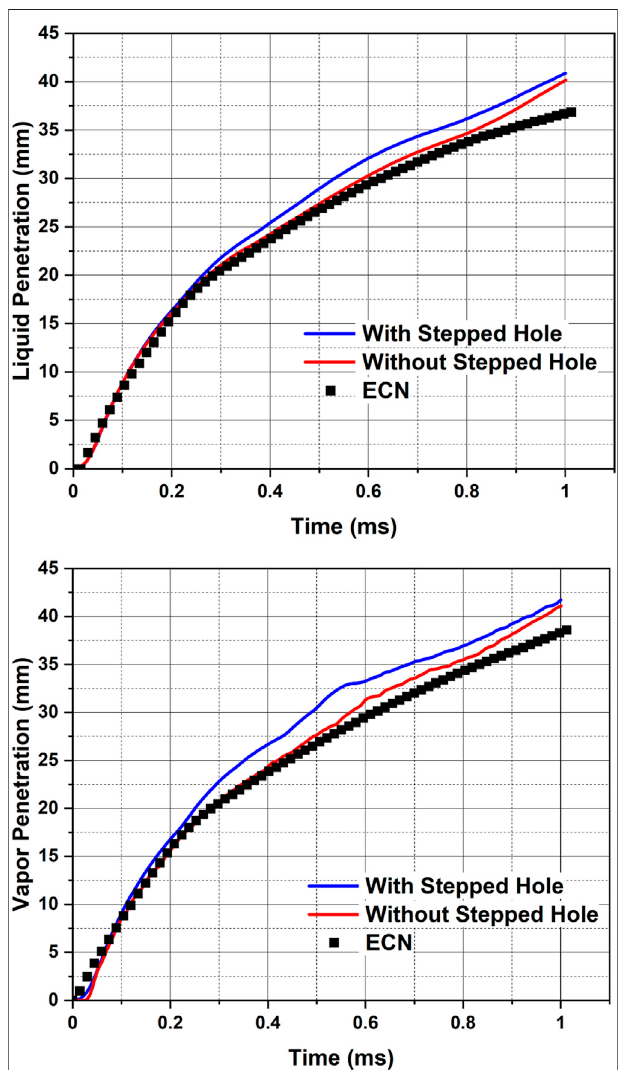
FIGURE 11 | Comparison of model predictions of liquid and vapor penetrations with the latest data measured by Sandia National Laboratories, available on ECN (ECN, 2022b) using LES Dynamic Structure turbulence model with and without the stepped holes in the computational domain [ B 1 = 32, C bl = 16, cone-angle 25 ° , plume targeting angle 35 ° ].